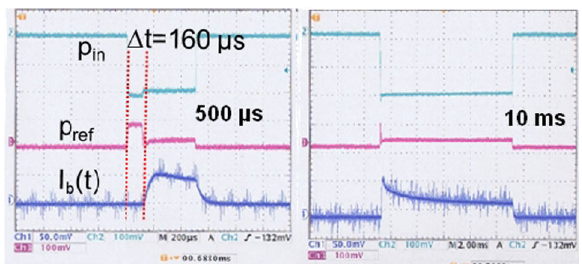
FIG. 3. Typical plasma buildup time with various durations. The green line represents the injected microwave power, the pink line denotes the reflected microwave power, and the blue line represents the ion beam current.